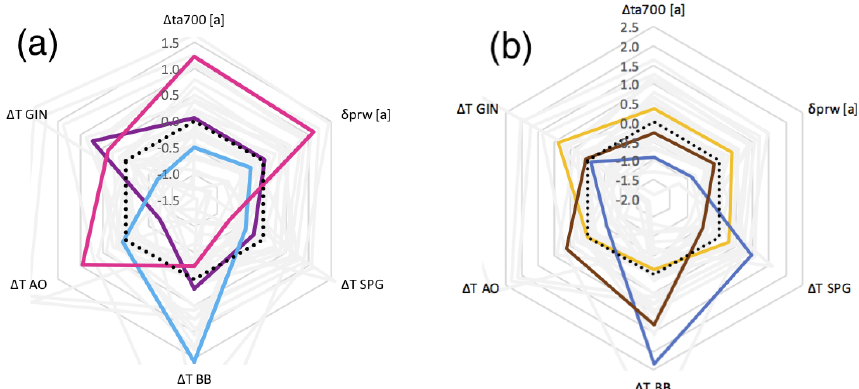
Figure 7. Normalized projected 21C changes for Greenland (with model ensemble in gray and the median in black). (a) Top three: HadGEM2-ES (pink), MIROC5 (purple), and NorESM1-M (light blue). (b) Top four to six: ACCESS1-3 (brown), CSIRO-Mk3-6-0 (dark blue), and IPSL-CM5A-MR (yellow). Ocean warming is calculated over four sectors (BB: Baffin Bay; AO: Arctic Ocean; GIN: Greenland– Iceland–Norwegian seas; SPG: Subpolar